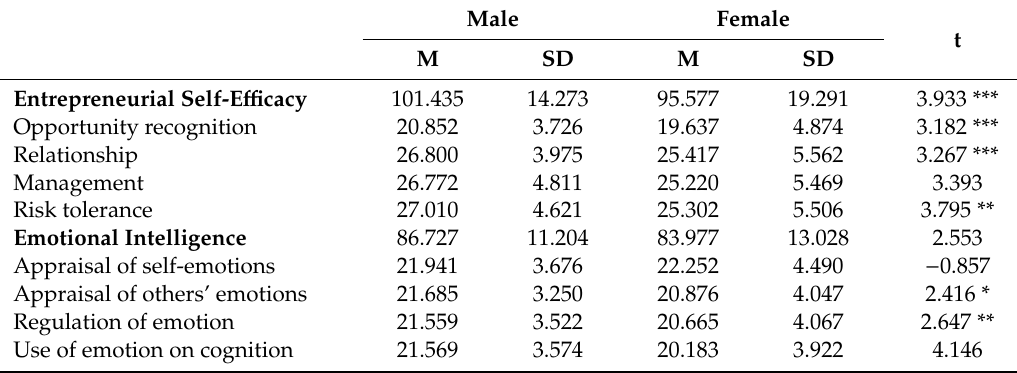
Table 7. Gender Di ff